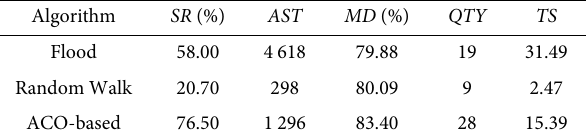
Table 2 Calculation results of the evaluation index of search algorithm Algorithm